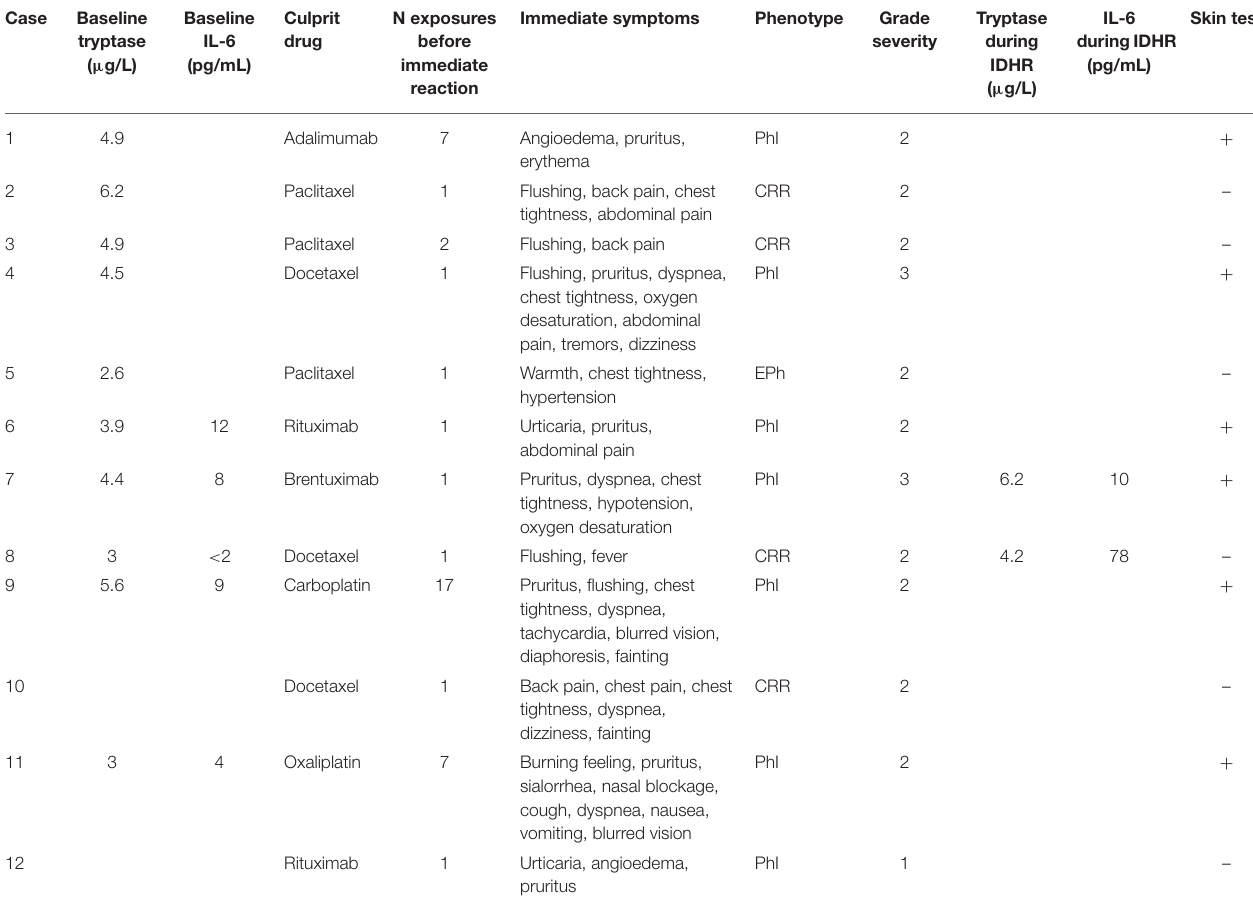
TABLE 2 | Characteristics of included patients at the moment of conversion to immediate hypersensitivity reactions.